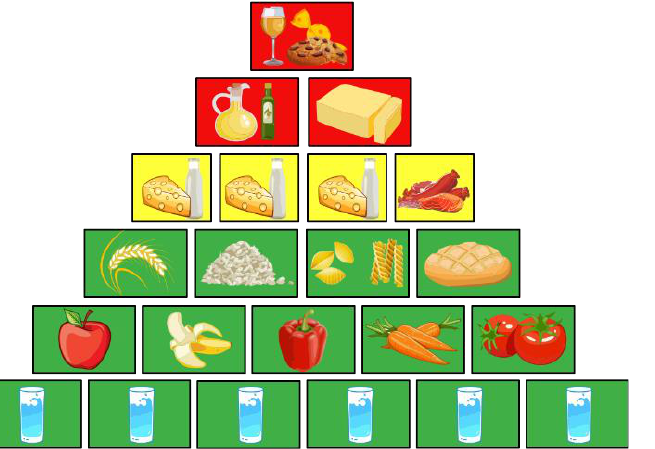
Figure 1. Recommended dietary intake by United Nations Plates, pyramids and planets based on an idea by S. Mannhardt — authors adaption after [27].